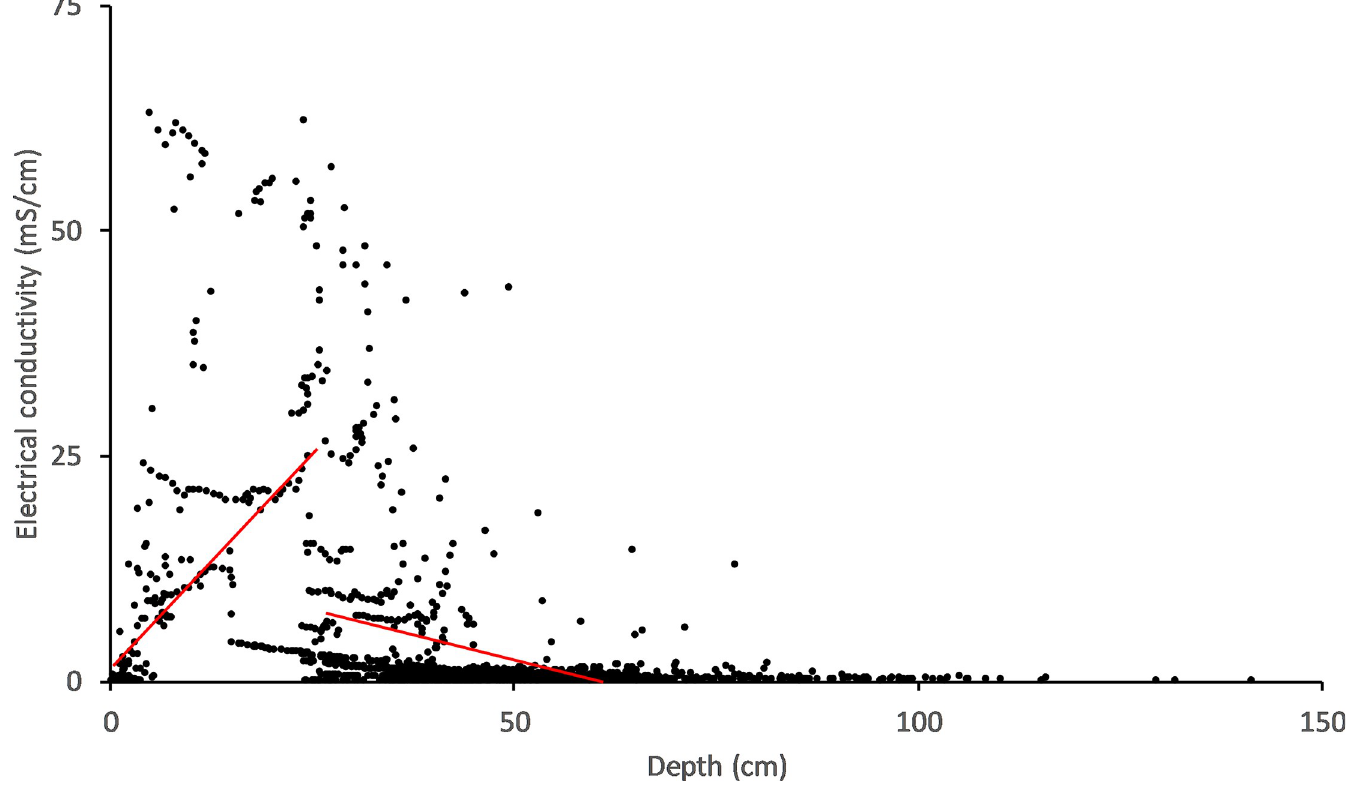
Fig 7. Piecewise visualisation of non-linear correlation between depth and EC. Red lines represent linear correlation segments from within the non-linear correlation. Here we can see increases in EC with Depth and decreases in EC with depth associated with tidal ingress and rainfall respectively.